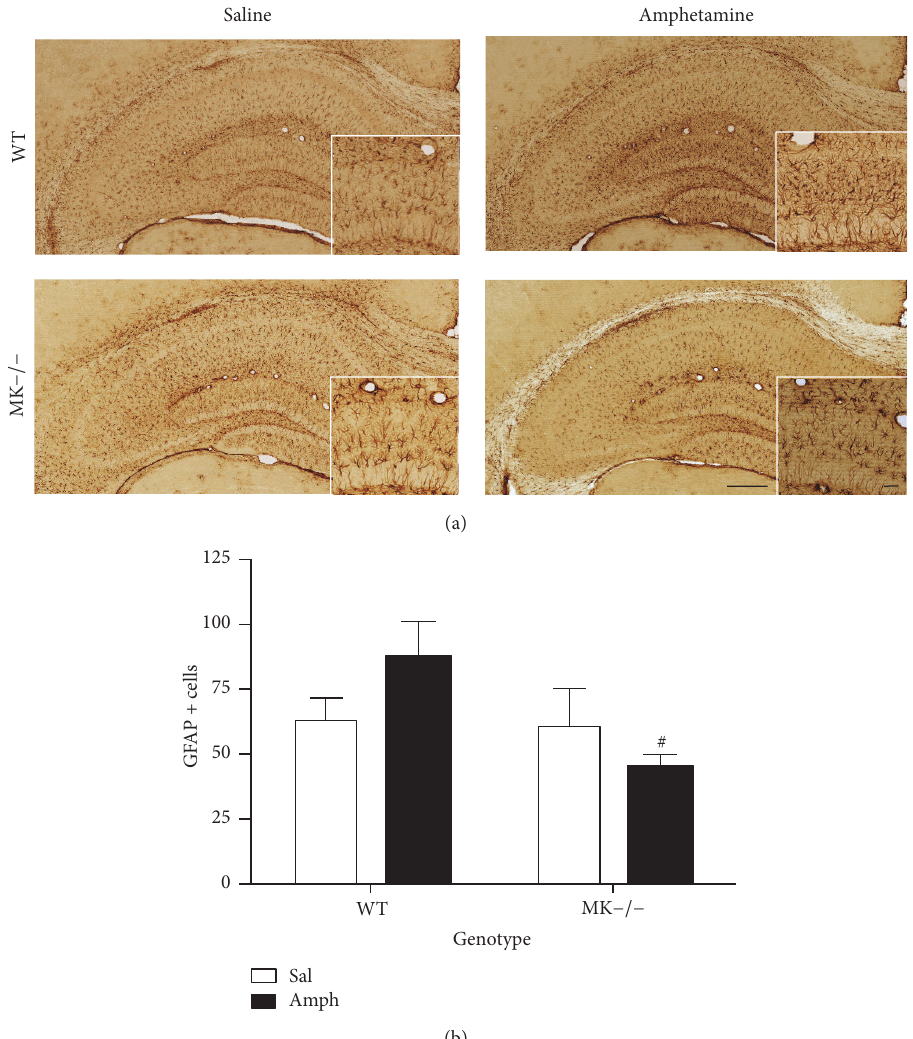
Figure 3: Amphetamine-induced astrocytosis in the hippocampus of WT and MK − / − mice. (a) Photomicrographs are from GFAP- immunostained hippocampal sections of saline- (Sal-) or amphetamine- (Amph-) treated animals. (b) The graph represents quantification of data (mean ± SEM) obtained from the counts of GFAP-positive cells in standardized areas of the CA1 region of hippocampus. A significant effect of the genotype ( F (1,12) = 4.88, 𝑃 = 0.04 ) was found. # 𝑃 < 0.05 versus WT. Scale bar = 200 𝜇 m. Magnified inset = 50 𝜇